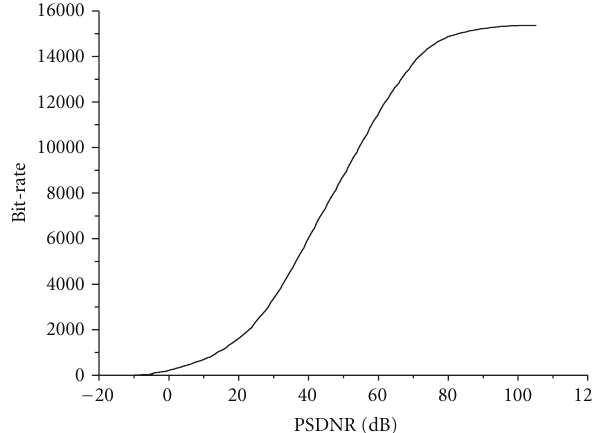
Figure 5: Target bitrate versus input PSDNR.